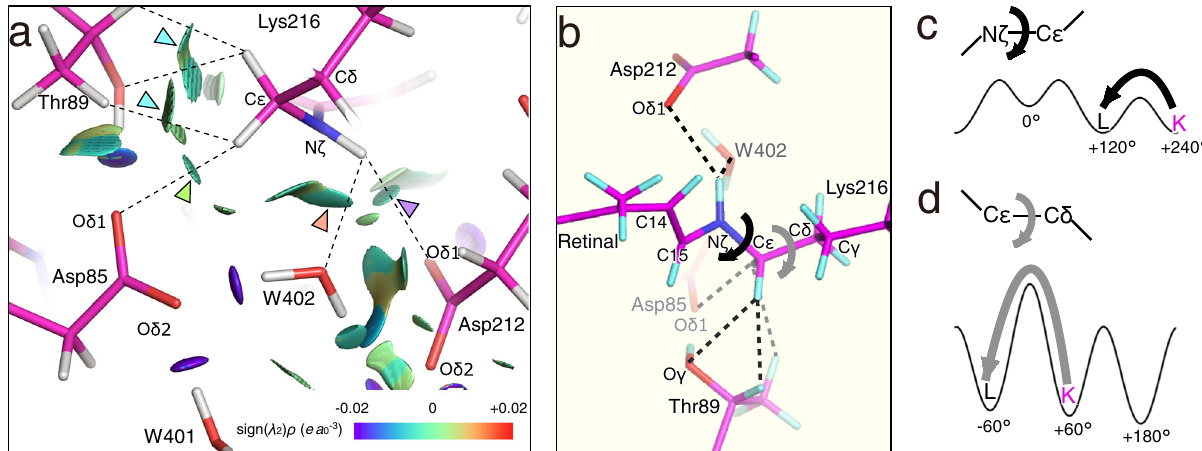
Fig. 6 Interactions stabilizing the retinal conformation of K. a The NCI plot for the EC side of the SB linkage. Hydrogen atoms are added according to the optimization with the QM/MM calculation. The reduced density gradient isosurface at s ( ρ ) = 0.5 is added as colored surfaces. The nature of the interaction can be visualized by the color according to the value of sign( λ 2 ) ρ in an atomic unit ( e a 0 − 3 ), where λ 2 and sign( λ 2 ) are the second eigenvalue of the Hesse matrix of ρ and its sign, respectively. The color scale are given at the right bottom of the panel. Blue, green and red correspond to attraction, weak attraction and repulsion, respectively. The blue arrows indicate the interaction between H atoms of C ε in Lys216 and Thr89. The green arrow indicates the interaction between H of C ε in Lys216 and Asp85. The orange arrow indicates the interaction between H of N ς in Lys216 and W402. The purple arrow indicates the interaction between H of N ς in Lys216 and Asp212. b Interactions with surrounding residues (Asp85, Thr89 and Asp212) and Water402 prevent torsional rotation at N ς – C ε and C ε – C δ bonds in Lys216. c The torsional potential energy curve for the N ς – C ε bond. The torsion angles in K/bR and L are ~ + 240° and + 120°, respectively. d The torsional potential energy curve for the C ε – C δ bond. The torsion angles in K/bR and L are approximately + 60° and − 60°,